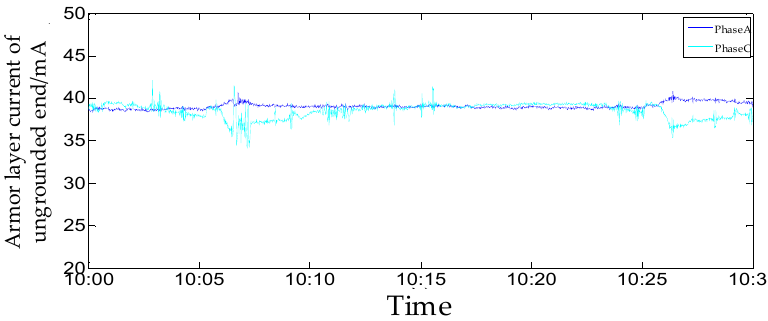
Figure 11. “Hukun 1” induced voltage at the ungrounded end of the cable sheath.